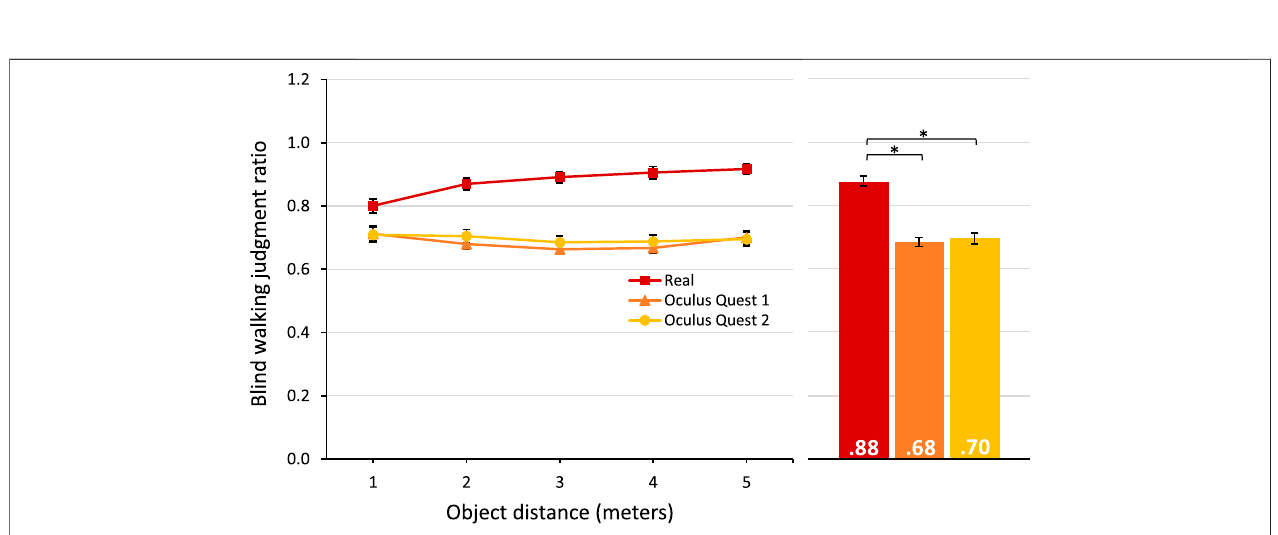
FIGURE3| Averageblindwalkingdistancejudgmentsexpressedasaratioofobjectdistance.Dataareplottedasafunctionofobjectdistance(linegraph,left),and also averaged across object distance (bar graph, right). Error bars represent ± one SEM. * p < 0 .05.